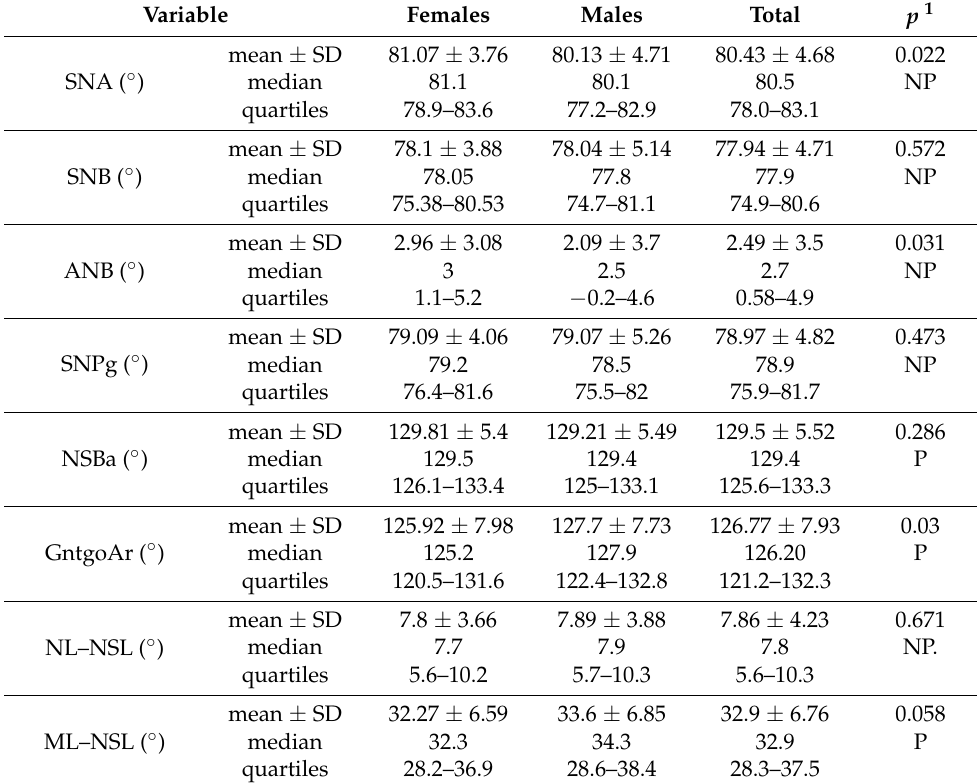
Table 5. Distribution of the study group according to nasal and cephalometric